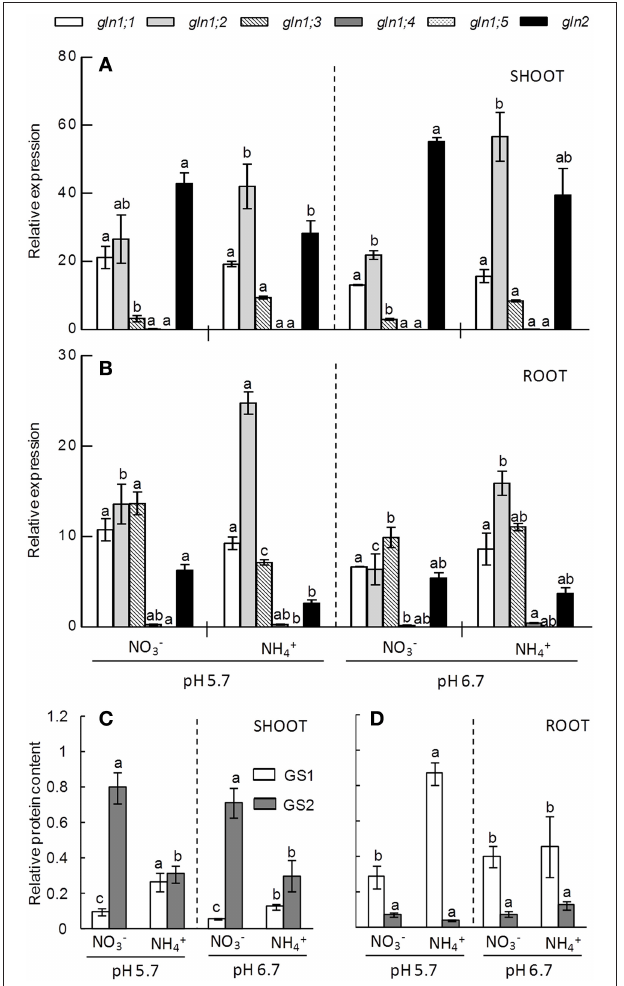
FIGURE 4 | GLN genes expression pattern of shoots (A) and roots (B) and GS enzyme content of shoot (C) and root (D) of plants grown under 10mM N concentration at pH 5.7 or 6.7 and NO − 3 or NH + 4 as N source. Letters represent significant differences between treatments analyzed by Duncan’s test ( p < 0.05 ). Columns represent mean ± se ( n = 3 ). Each sample is a pool of three plants. In Supplementary Figure 6 a zoom of gln1;4 and gln1;5 genes expression is available.